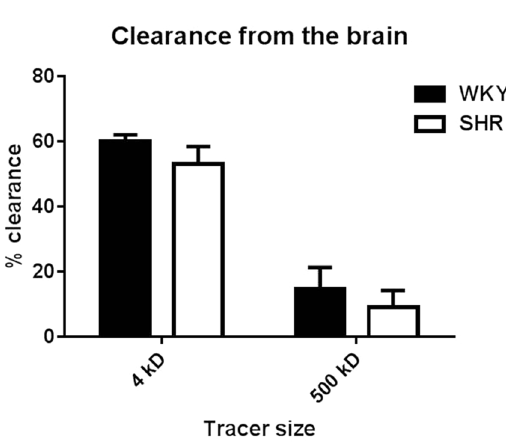
Figure 3. Clearance of tracers from the hippocampus. Clearance was calculated as the amount of tracer removed from the brain as percentage of the initially injected quantity. There was no difference in clearance for both the low and high molecular weight tracer in WKY as compared to SHR. Clearance was larger for the small tracer (3 kD) as compared to the large tracer (500 kD; P < 0.00001). WKY = 6 SHR = 6. Data are mean ±